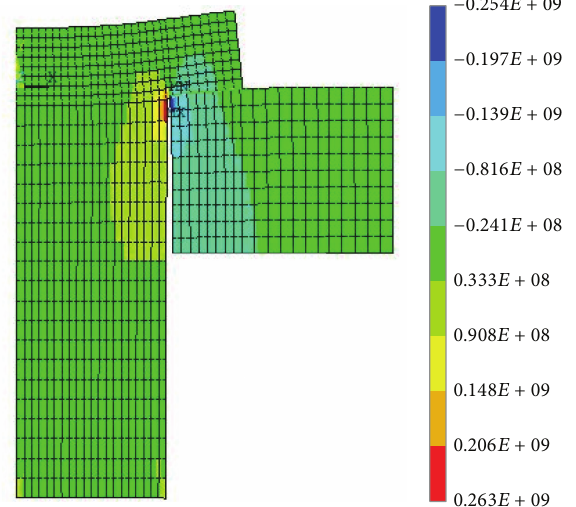
Figure 4: 2D finite element model. Figure 5: